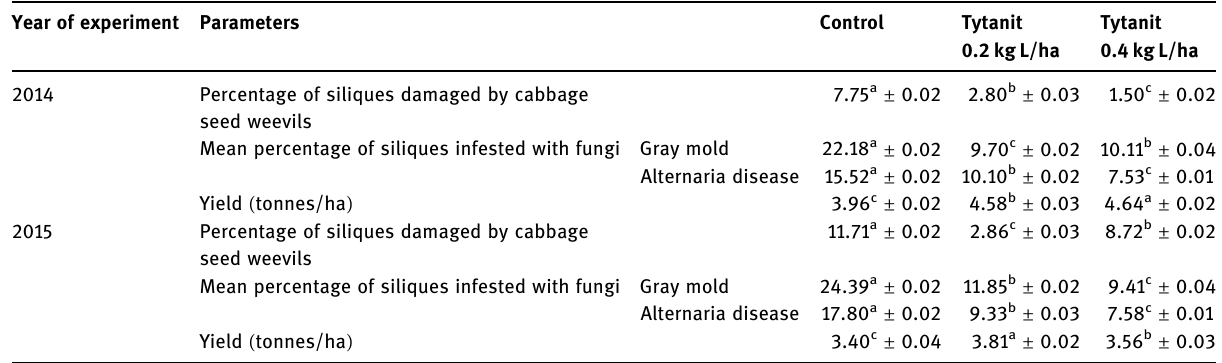
Table 2: The results of experiments on winter oilseed rape. Mean values ± standard deviations Year of